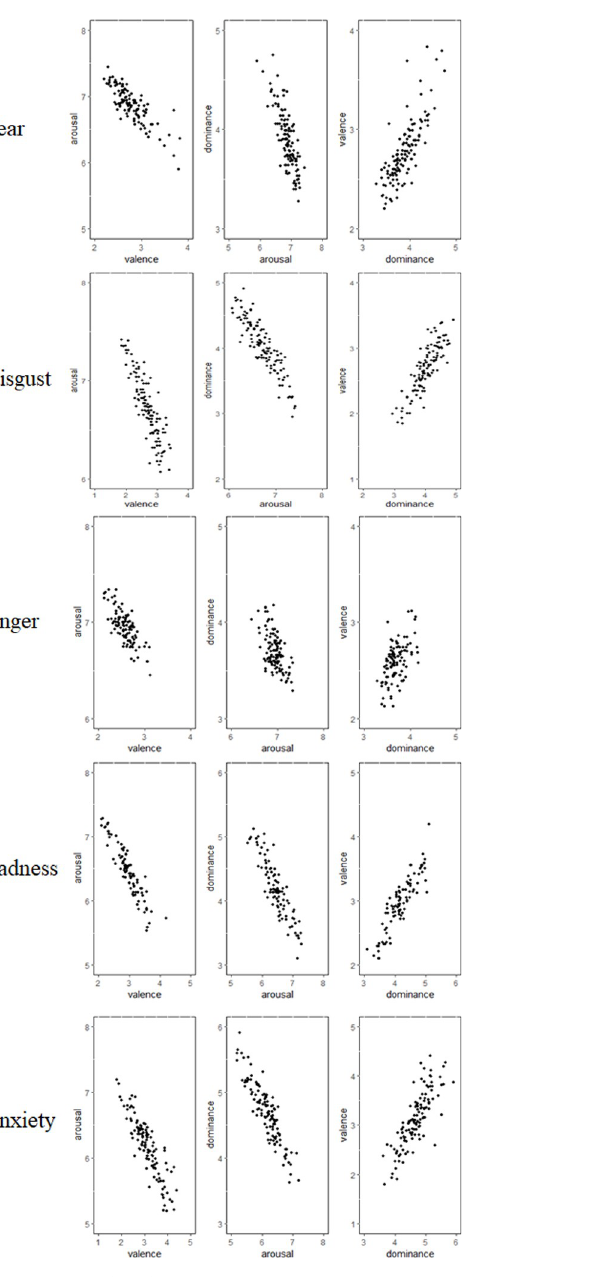
Fig 2. Scatterplot of negative